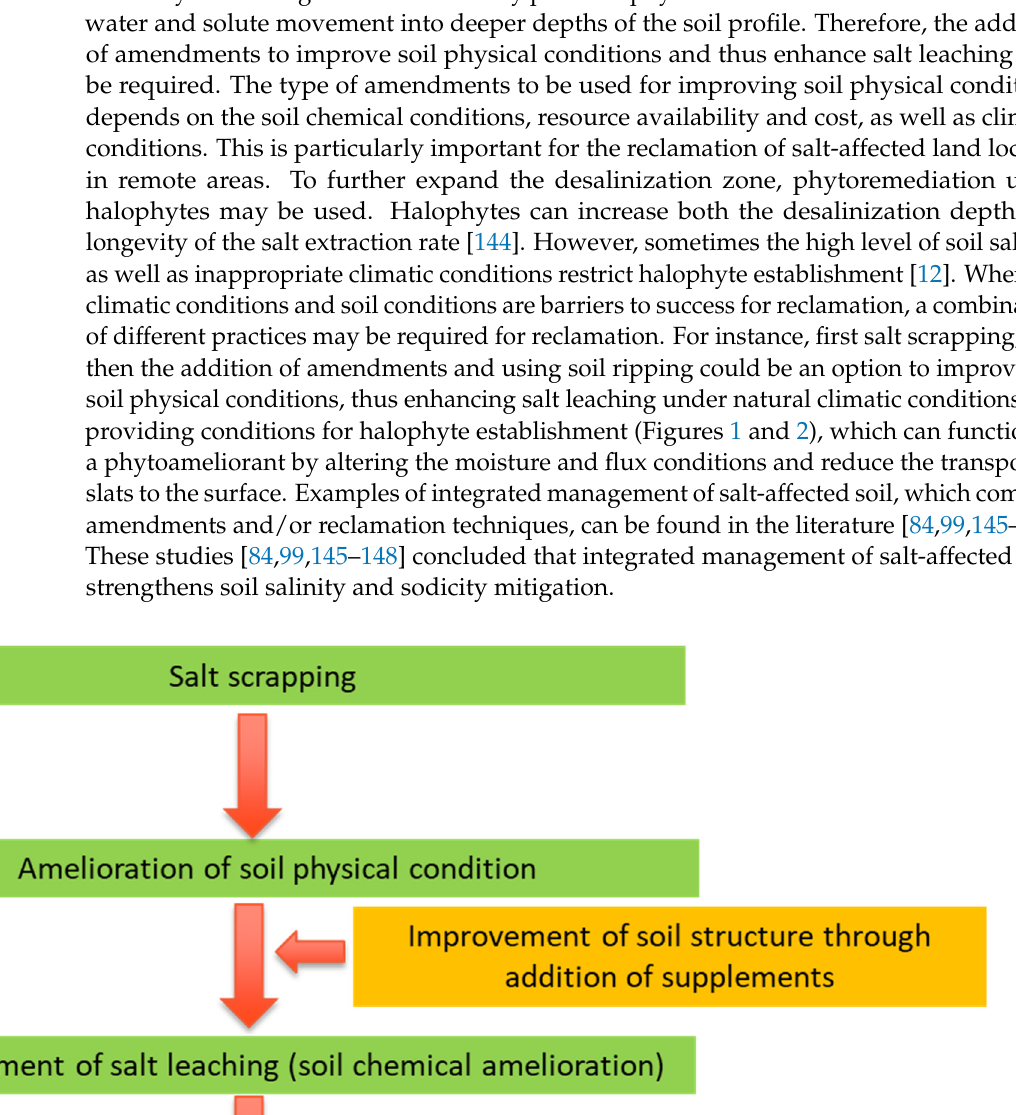
Figure 2. Conceptual model of reclamation of salt-affected area ( a ) before reclamation, ( b ) after rec- lamation .